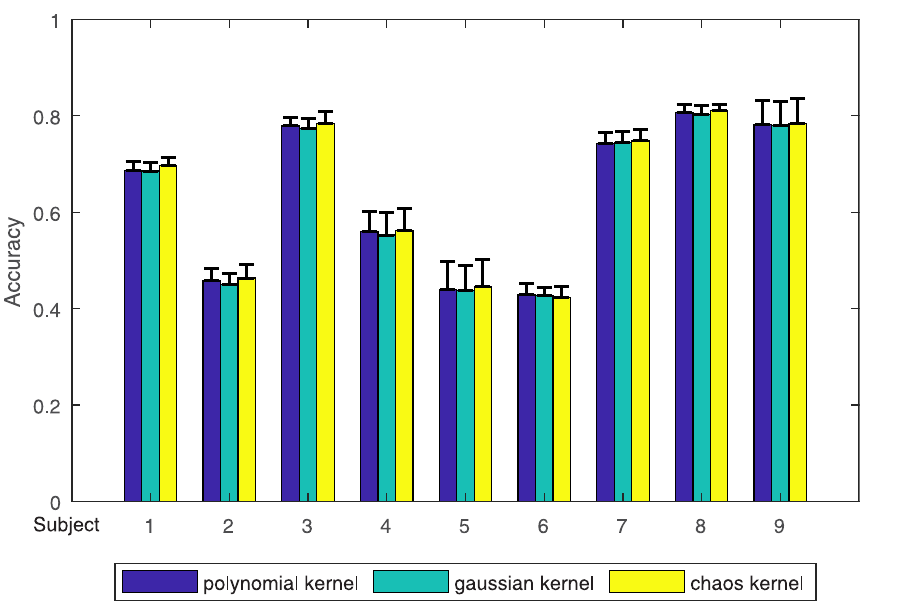
Fig 10. The overall classification result on two sessions.